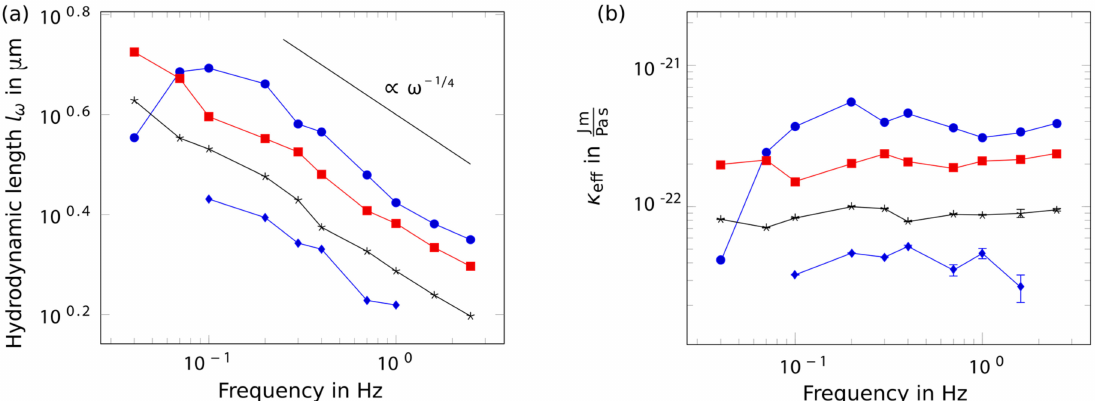
Figure 2. Hydrodynamic length and persistence length. Different colors and markers depict different individual bundles of varying thicknesses (blue dotted: thin bundle, blue circles: thick bundle, others: intermediate). ( a ) Regarding the frequency dependence of the hydrodynamic length, wiggling bundles with a bead attached to their ends revealed a power law exponent of − 1/4; ( b ) which translated into a constant bending stiffness. Few bundles, however, also showed a softening behavior towards low